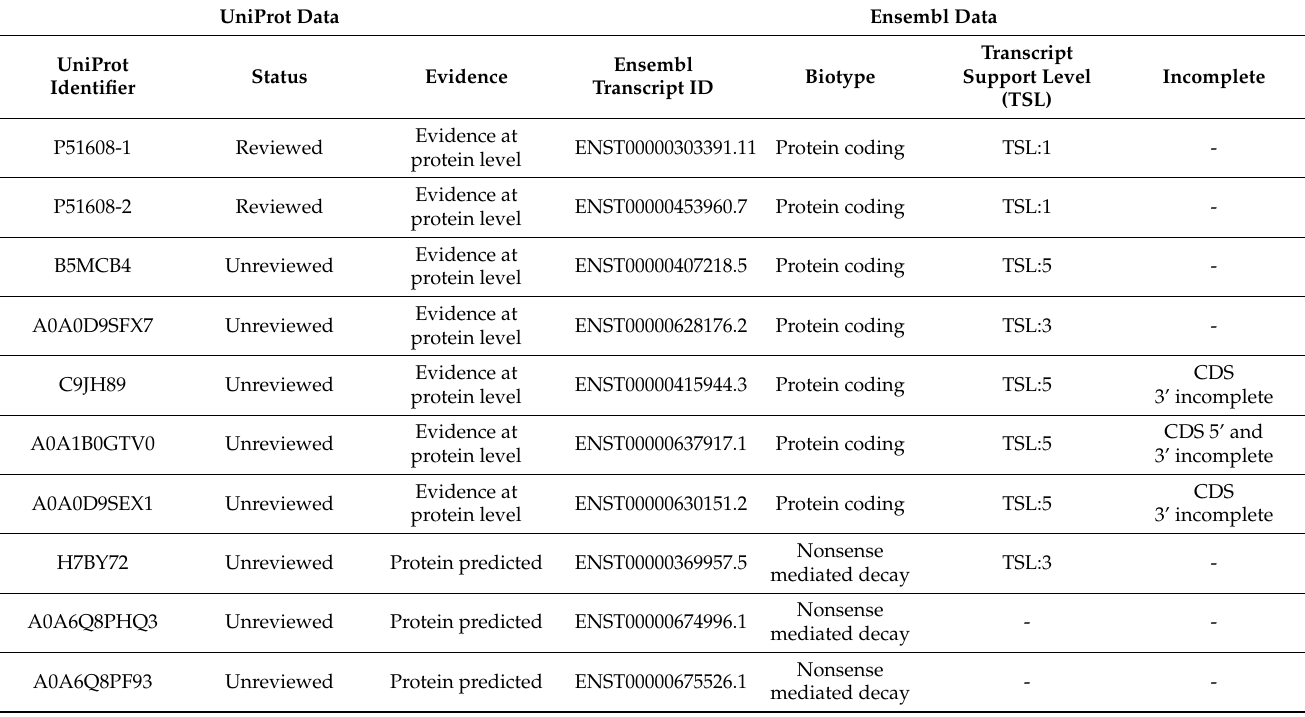
Table 2. Summary of UniProt MeCP2 protein isoform variants and their respective transcripts from Ensembl (Updated 15 October